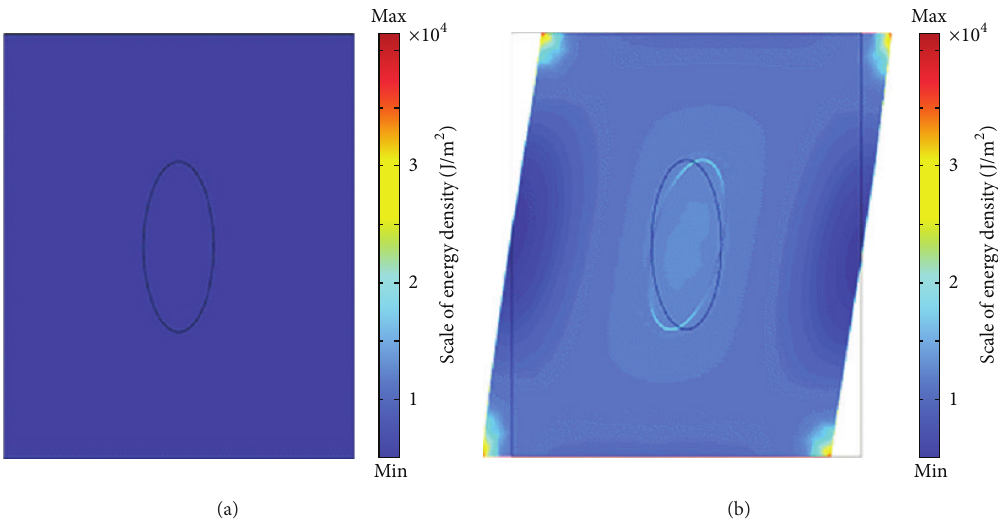
Figure 17: Some shots illustrating the cube deformation in shearing at 𝜎 = 0 (a) and 50 kPa (b). Dark blue color shows the initial ellipsoid; the light blue corresponds to the deformed ellipsoid. Colors correspond to the scale of the elastic energy density.